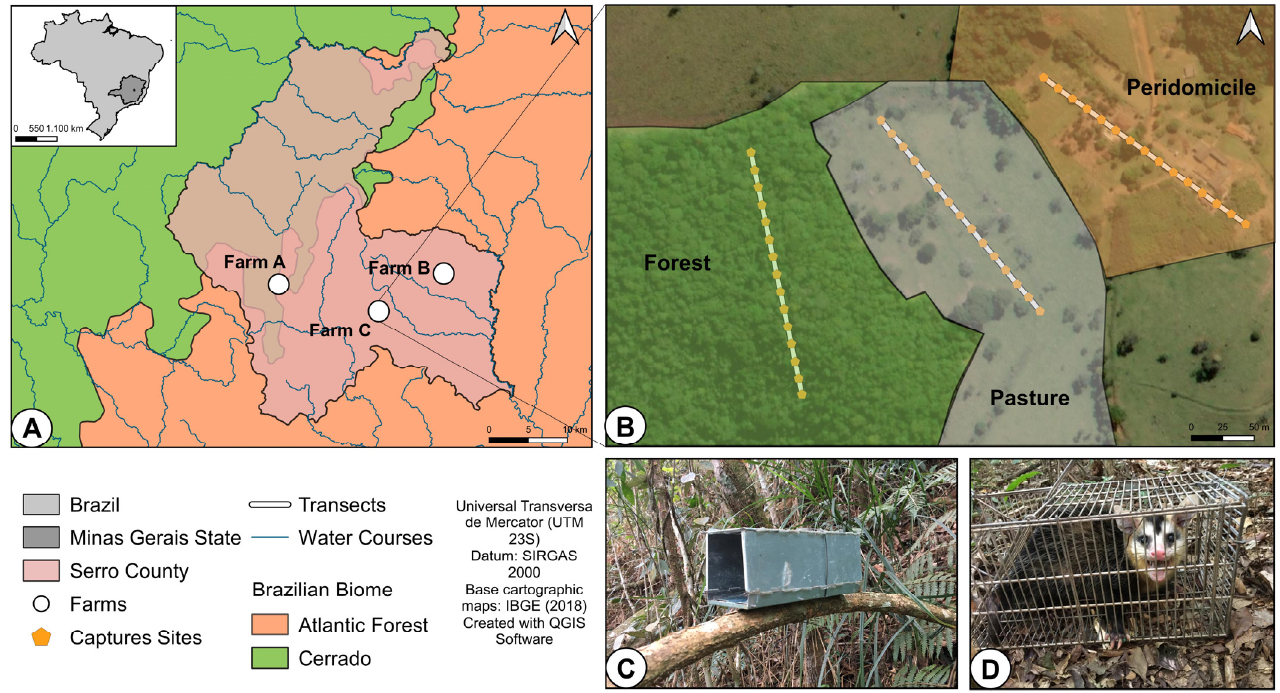
Figure 1. Geographic location, sampling design, and traps used during the study in Serro-MG, Brazil. ( A ) Map of Serro county (pink), water courses are blue lines and the Brazilian biomes intersecting in this region are depicted: Cerrado Biome in green and Atlantic Forest Biome in orange. Map inset at the top left shows the location of the State of Minas Gerais. Farms selected for the study are indicated by white circles. ( B ) Sampling design in one of the farms, showing three transects (white lines), with the fifteen capture sites each (yellow pentagons). ( C ) Sherman live-trap positioned on a tree branch. ( D ) Tomahawk-like cage positioned on the ground with a common opossum ( Didelphis aurita ) captured.